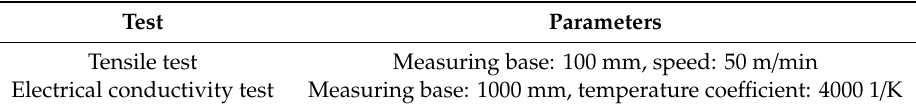
Table 4. Parameters of the mechanical and electrical property tests.